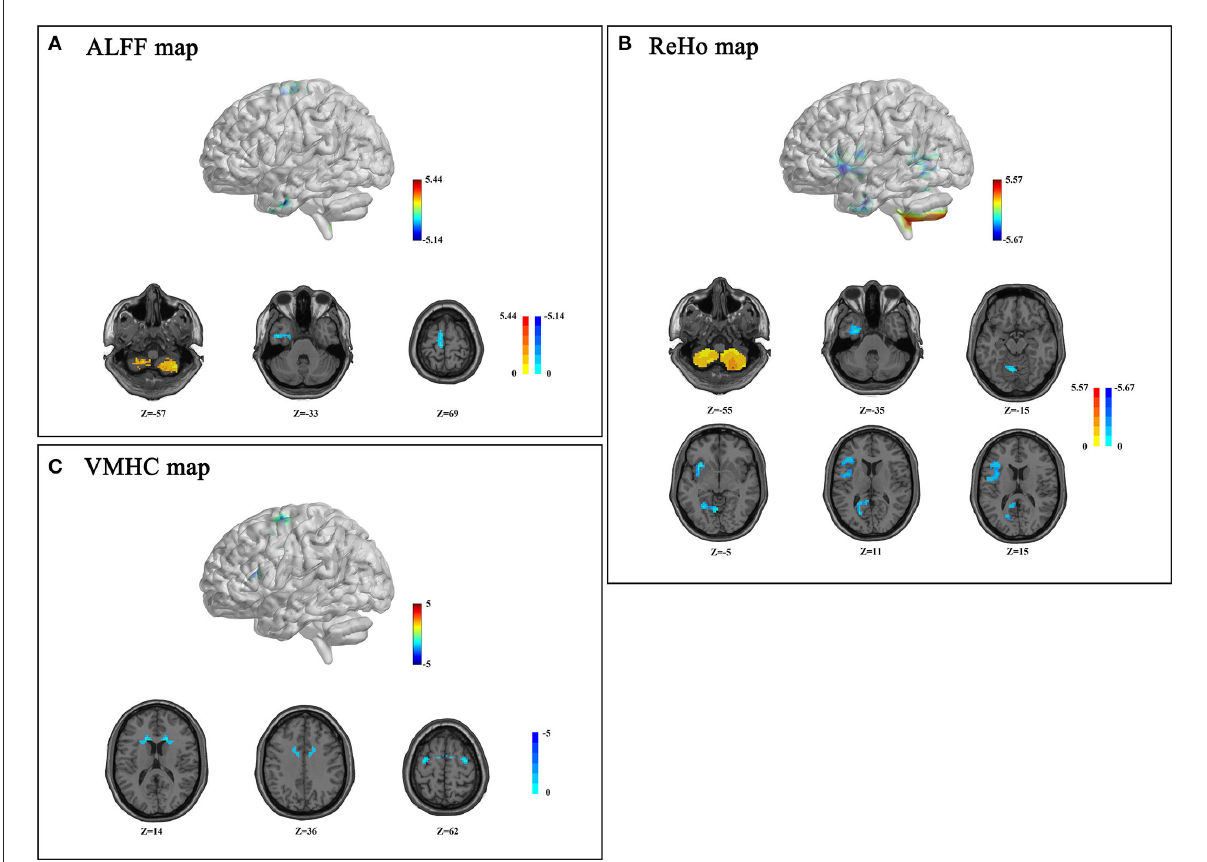
FIGURE1 Amplitude of low-frequency fluctuation (ALFF) (A) , regional homogeneity (ReHo) (B) , and voxel-mirrored homotopic connectivity (VMHC) (C) differences between patients with type 2 diabetes mellitus (T2DM) and control subjects ( p < 0.05, Gaussian Random Field (GRF) corrected). (A) Patients with T2DM presented decreased ALFF values in the bilateral inferior cerebellum, left inferior temporal gyrus (ITG.L), and supplementary motor area (SMA.L). (B) Patients with T2DM showed decreased ReHo values in the left cerebellum, joint areas of INS/IFG/ROL.L, LING/PCG/PCUN.L, FFG/ITG/PHG.L and increased ReHo value in the bilateral inferior cerebellum; (C) Patients with T2DM showed decreased VMHC in CAU, DCG, PreCG, and SMA. Color scale denotes the t -value. The z -value is the Montreal Neurological Institute (MNI)